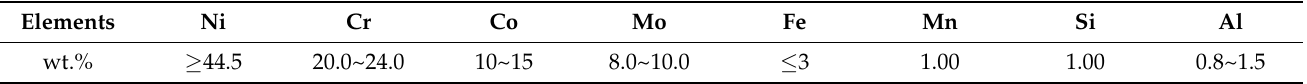
Table 1. The main chemical composition of alloy